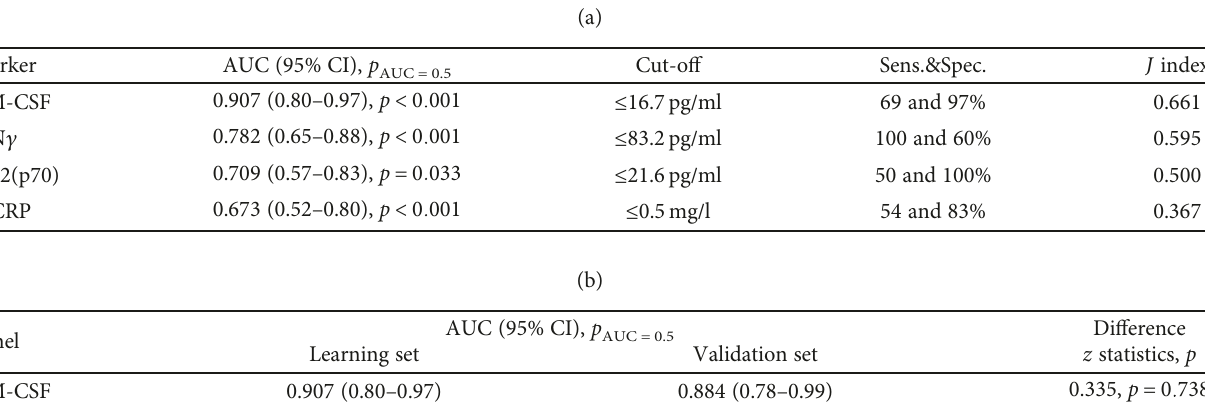
Table 3: Diagnostic power of eosinophil-associated cytokines as negative markers of mucosal healing in UC.